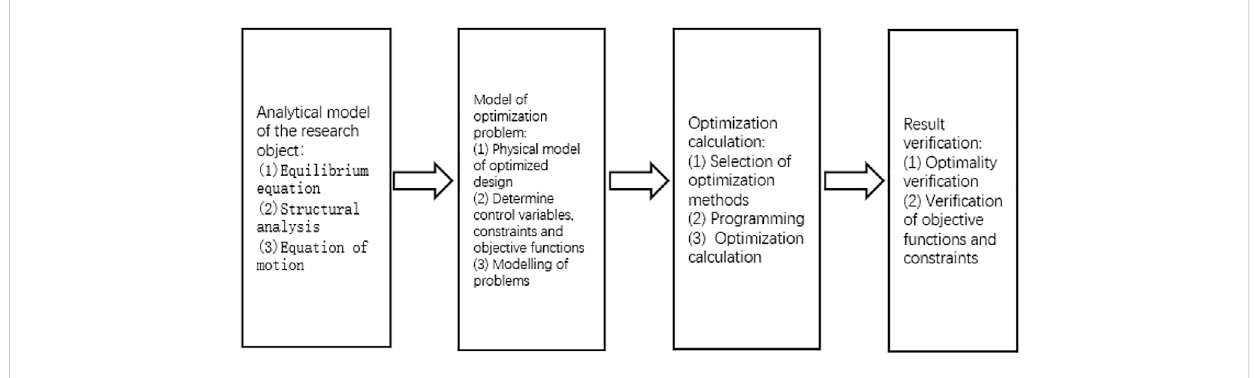
FIGURE 3 Basic process of optimization design.